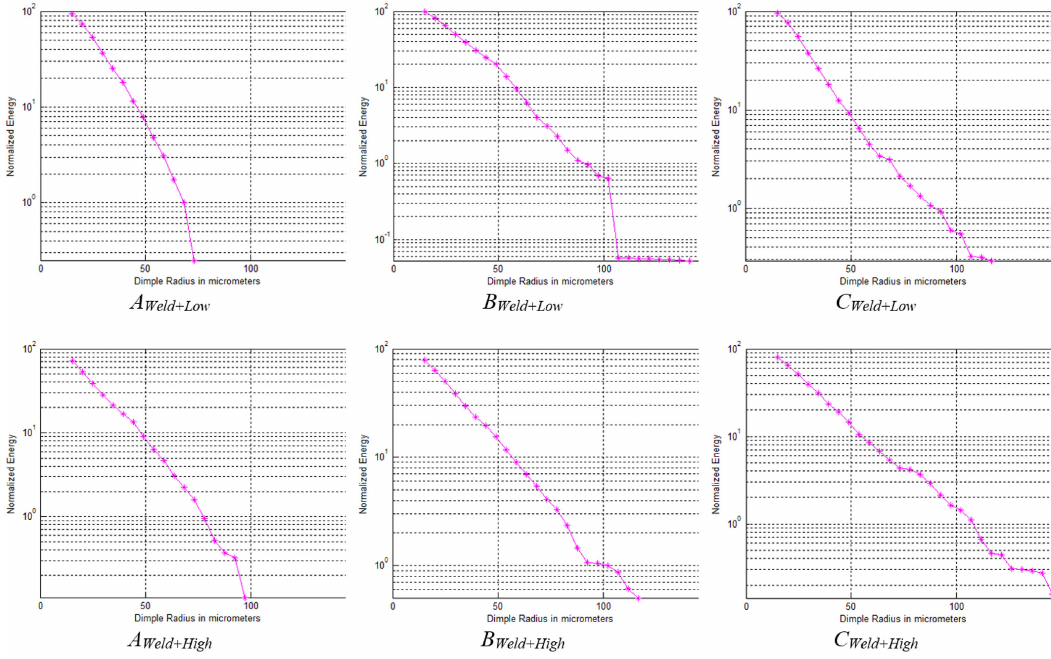
Figure 14. Dimple size distribution for two shot-peened samples with high and low intensity and three regions each.